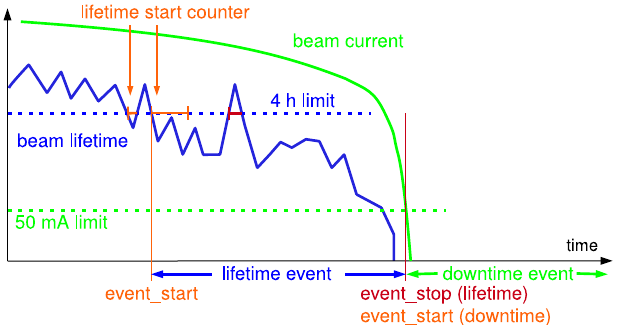
FIG. 3. (Color) The example shows a lifetime event as defined in Sec. I. The event-start counter had been reset the first time, since the beam lifetime came back above 4 hours before it finished. The second time the counter finished and the event started. The stop counter started once but had been reset when the lifetime dropped again below 4 hours. The event stopped when the beam current dropped below 50 mA: that started a downtime event which has